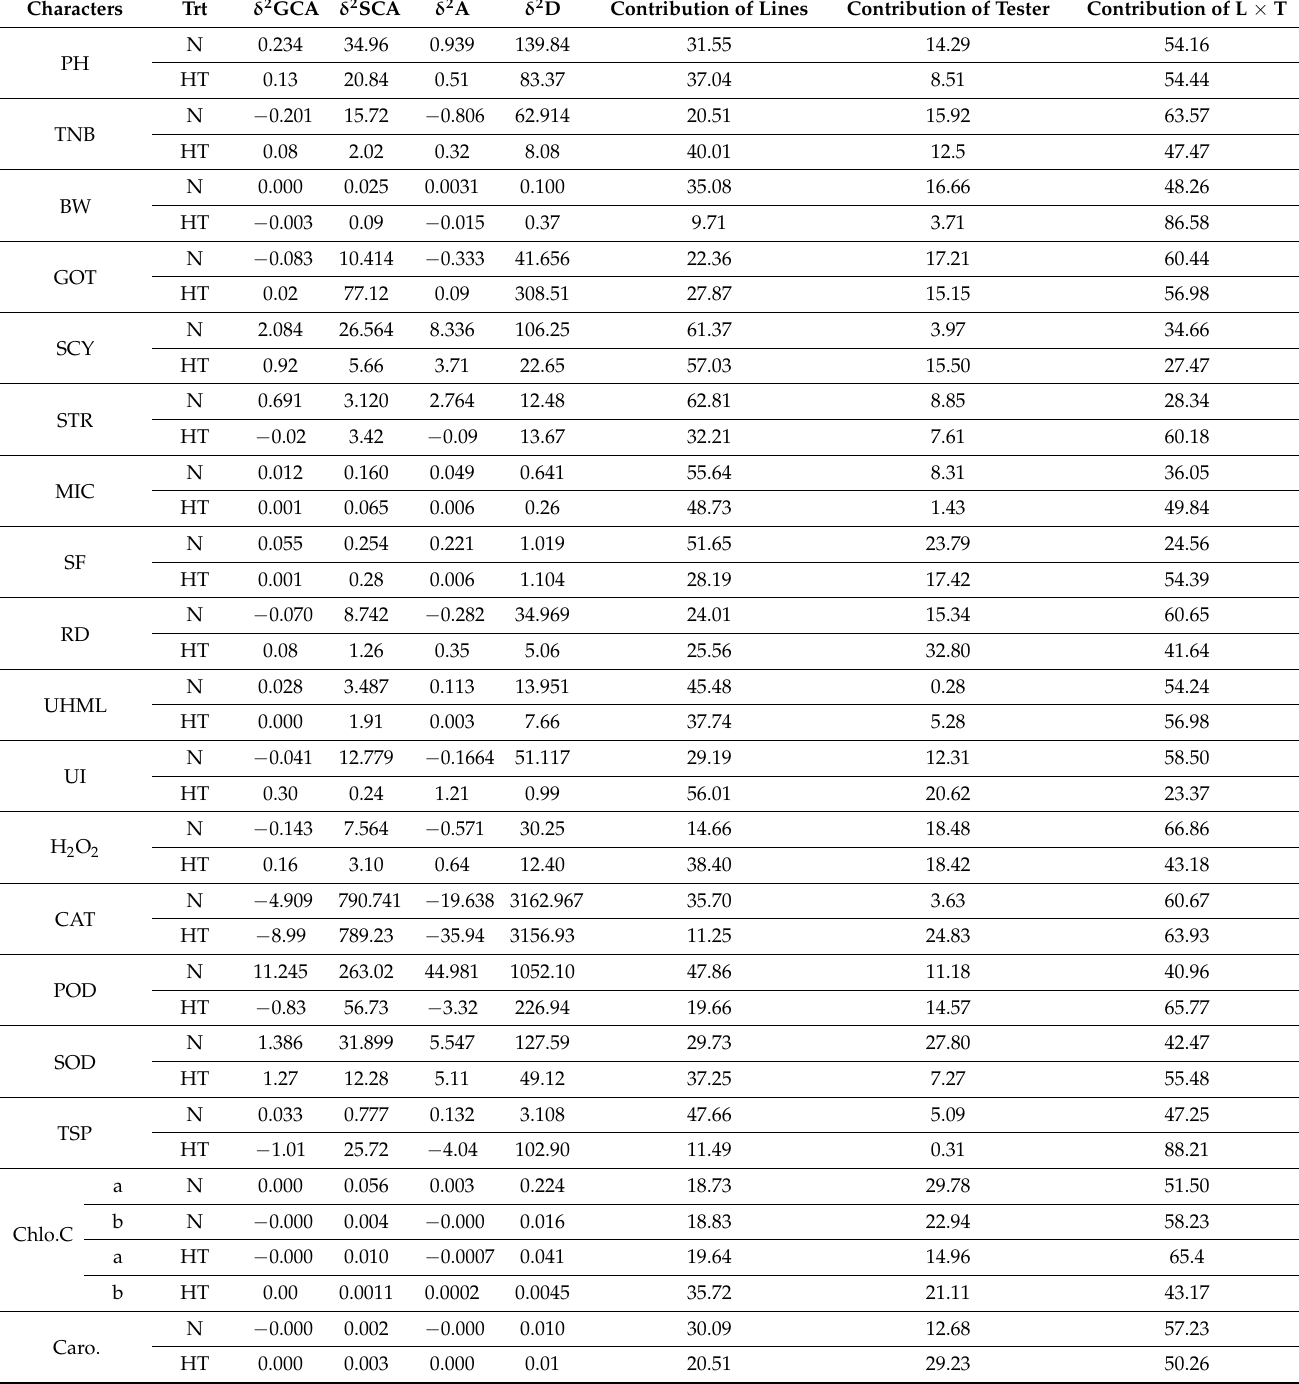
Table 9. Second year genetic components and proportional contribution of lines, testers, and their interactions to total variance under normal and high temperature stress